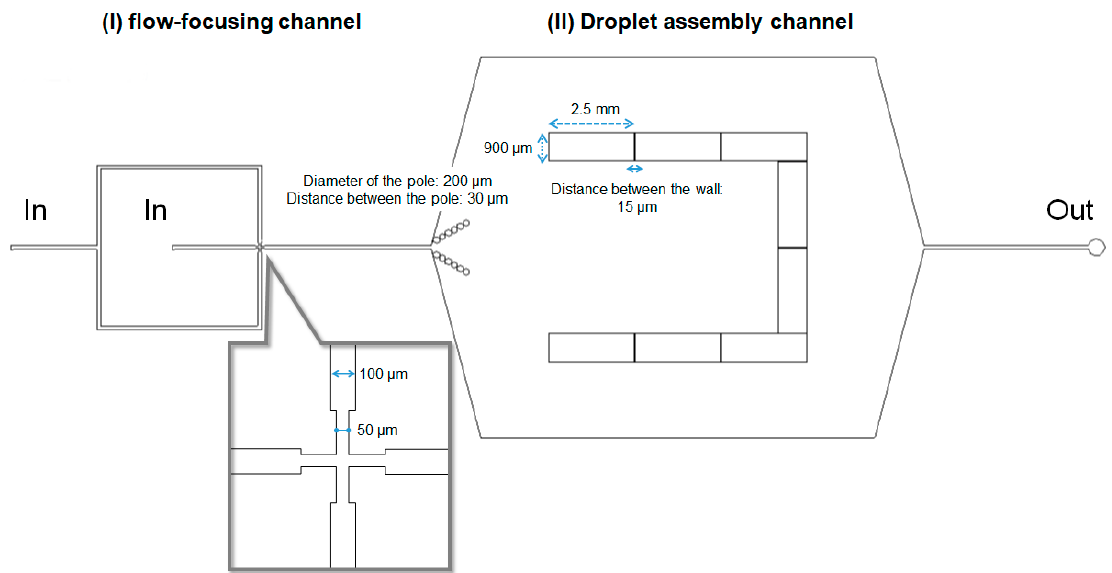
Figure 2. Schematic of the microfluidic device for spontaneous formation of honeycomb-patterned droplets. In section I, droplets were generated by a flow-focusing mechanism. In section II, the generated droplets were trapped and assembled in a U-shaped chamber.